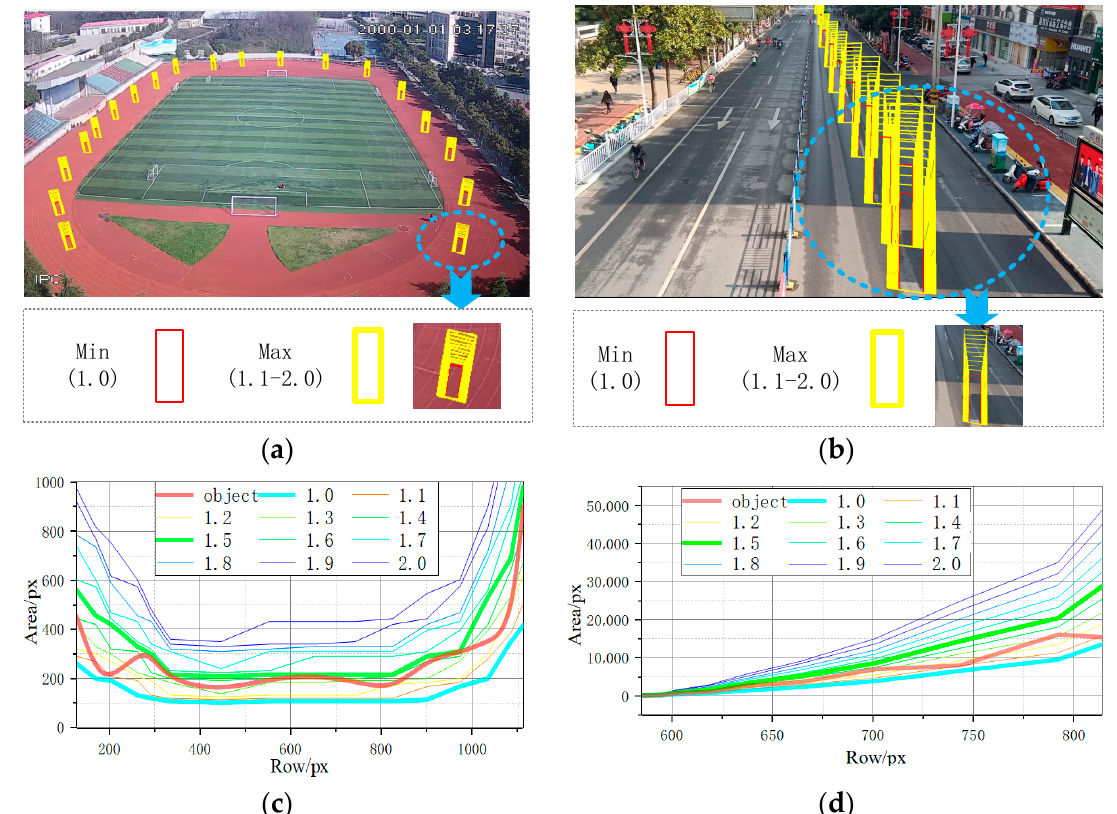
Figure 8. Maximum threshold range of videos #1 and #2: Object location and threshold range of ( a ) video #1 and ( b )